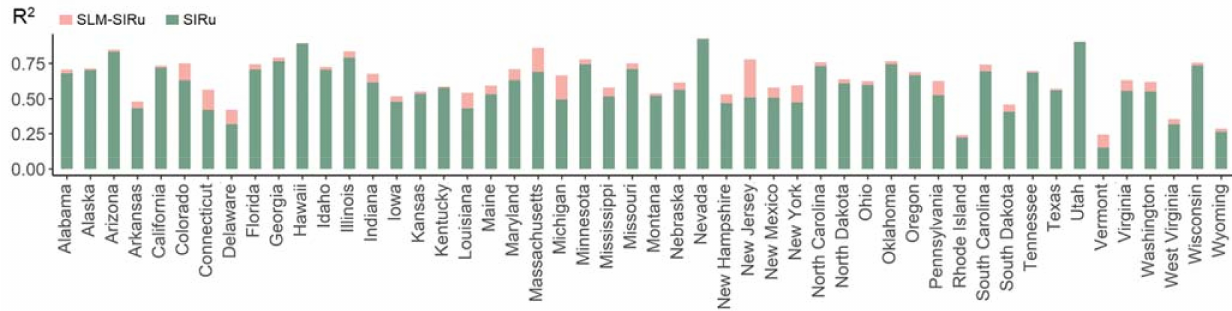
Figure 5. Fitness comparison of SLM-SIRu and SIRu. The R 2 range of the original SIRu was 0.1490–0.9250 (mean = 0.5894), while that of SLM-SIRu was 0.2399–0.9303 (mean = 0.6443); thus, the percentage of R 2 improvement was 0.35%–62.72% with a mean of 11.54%.